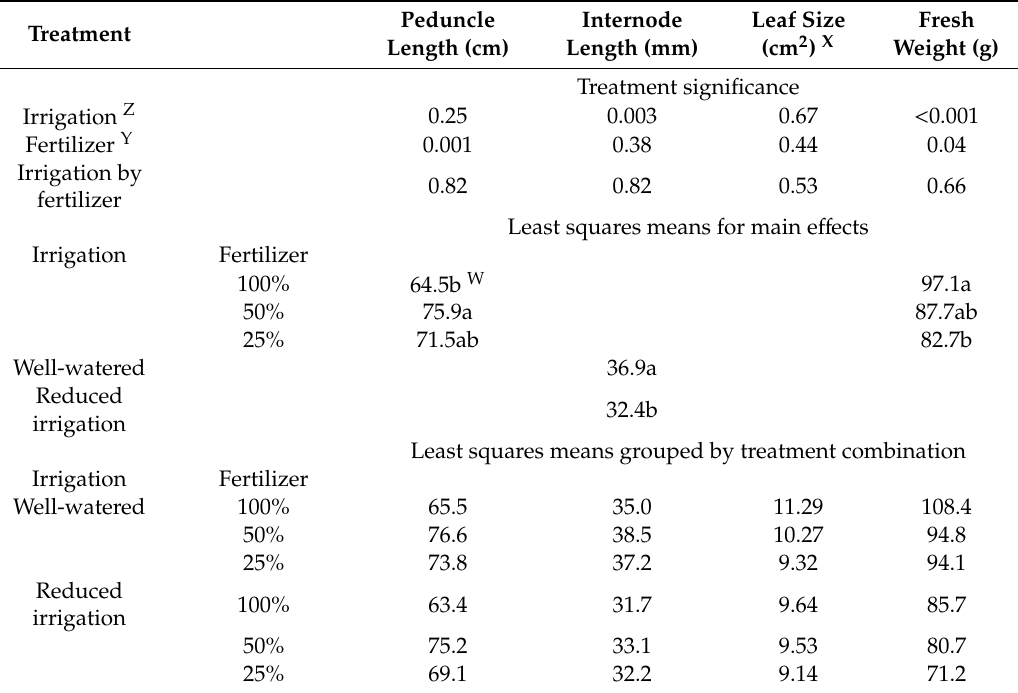
Table 1. Growth measurements for ‘Ruby Candle’ beardtongue in response to irrigation and fertilizer rate treatments at the conclusion of the 73 d